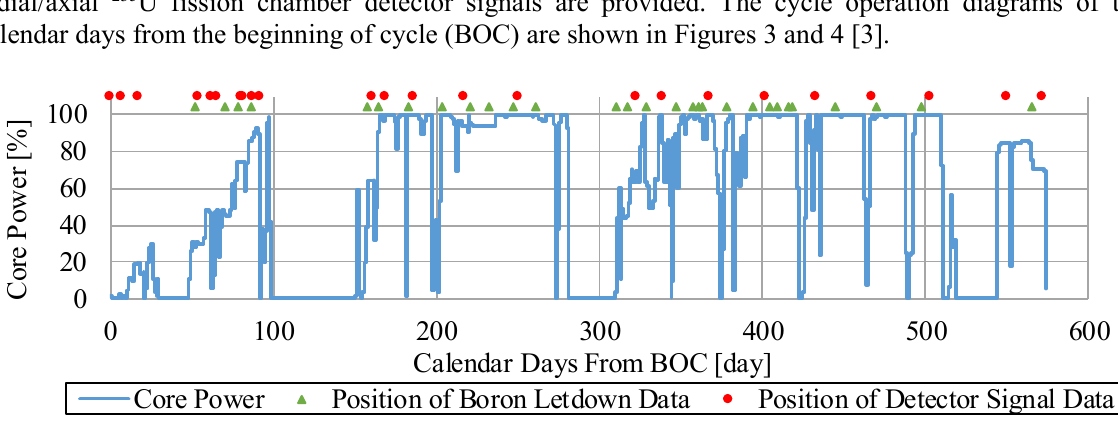
Figure 3. Cycle 1 Operation